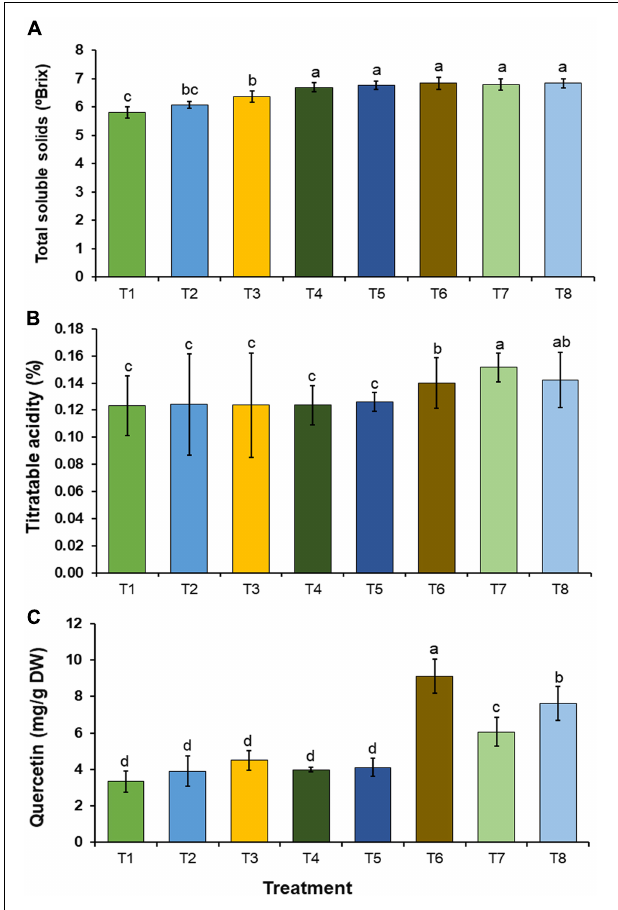
FIGURE 8 | Chemical constituents in onion bulb. (A) Total soluble solids, (B) titratable acidity, (C) quercetin content. Error bars represent the standard deviation of the mean. The different letters indicate significant difference ( p ≤